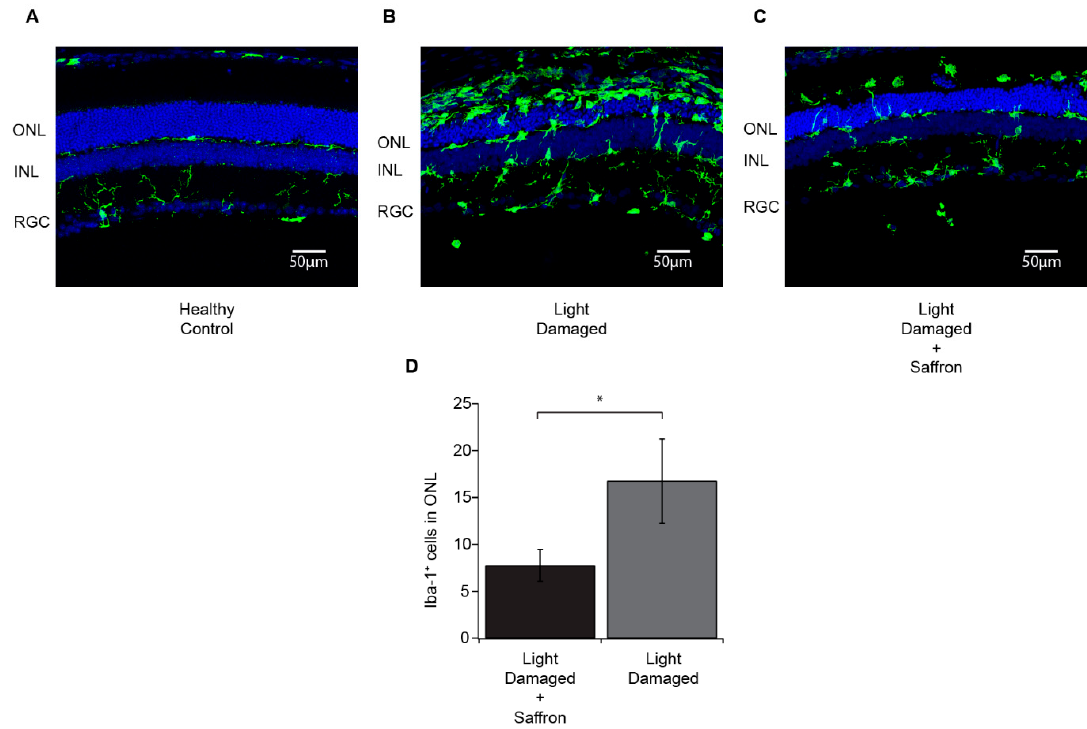
Figure 2. Microglia (in green) in Healthy Control ( A ), Light damaged ( B ) and Light damaged + Saffron ( C ) groups. In Healthy animals, microglia are resident in the inner retina and are absent in the outer nuclear layer (ONL) ( A ). Following light damage, resident microglia from the INL and invading microglia from the choroid migrate into the outer nuclear layer (ONL) ( B ). Saffron treatment significantly reduces the amount of microglia in the outer nuclear layer (ONL) after light damage compared to the untreated group ( C ). Number of microglia quantified, on average, in each field in the outer nuclear layer (ONL) ( D ). The mean ± SE is reported. ( p < 0.05). Images taken in corresponding dorsal region “hot spot”. ONL = outer nuclear layer; INL = inner nuclear layer; RGC = retinal ganglion cell layer. Antioxidants 2019 , 8 , x FOR PEER REVIEW